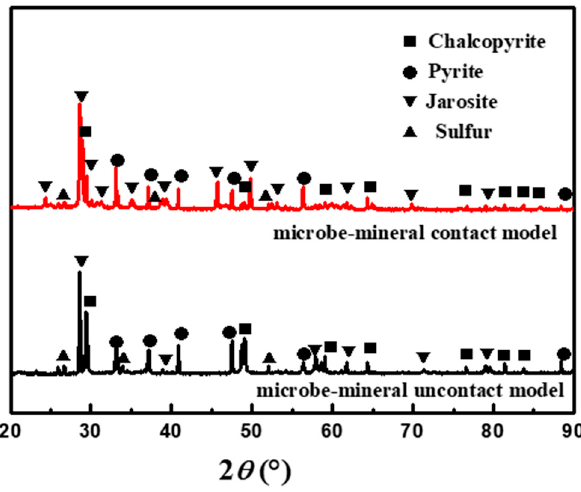
Figure 6. XRD spectra of the leaching residue after 30 days.